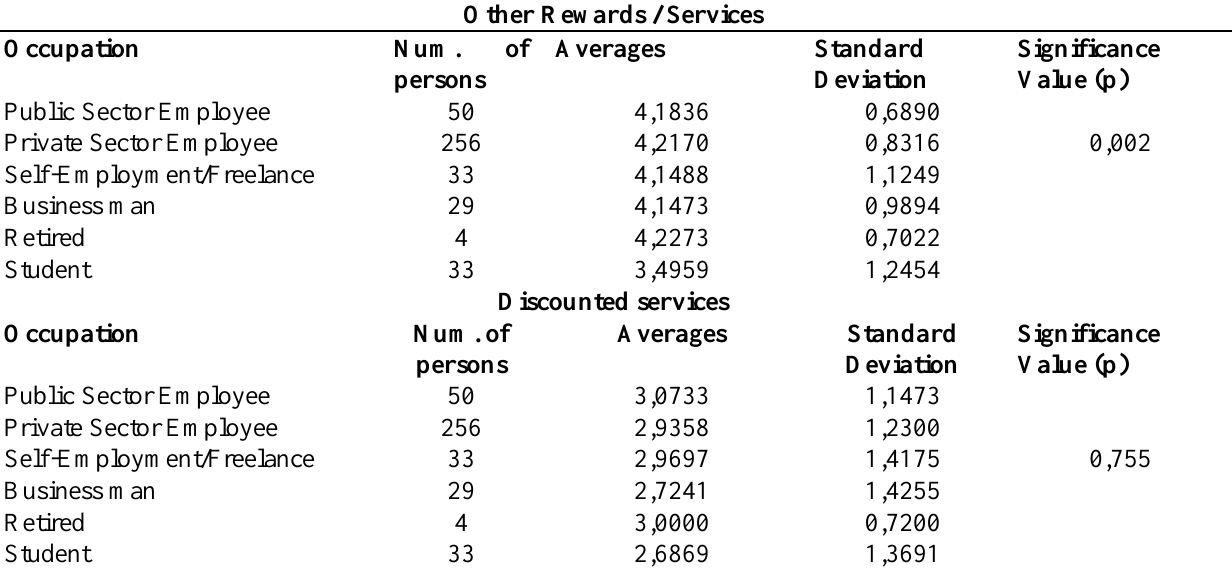
Table 11. Comparison of the views regarding the perception of the rewards/services offered under FFP